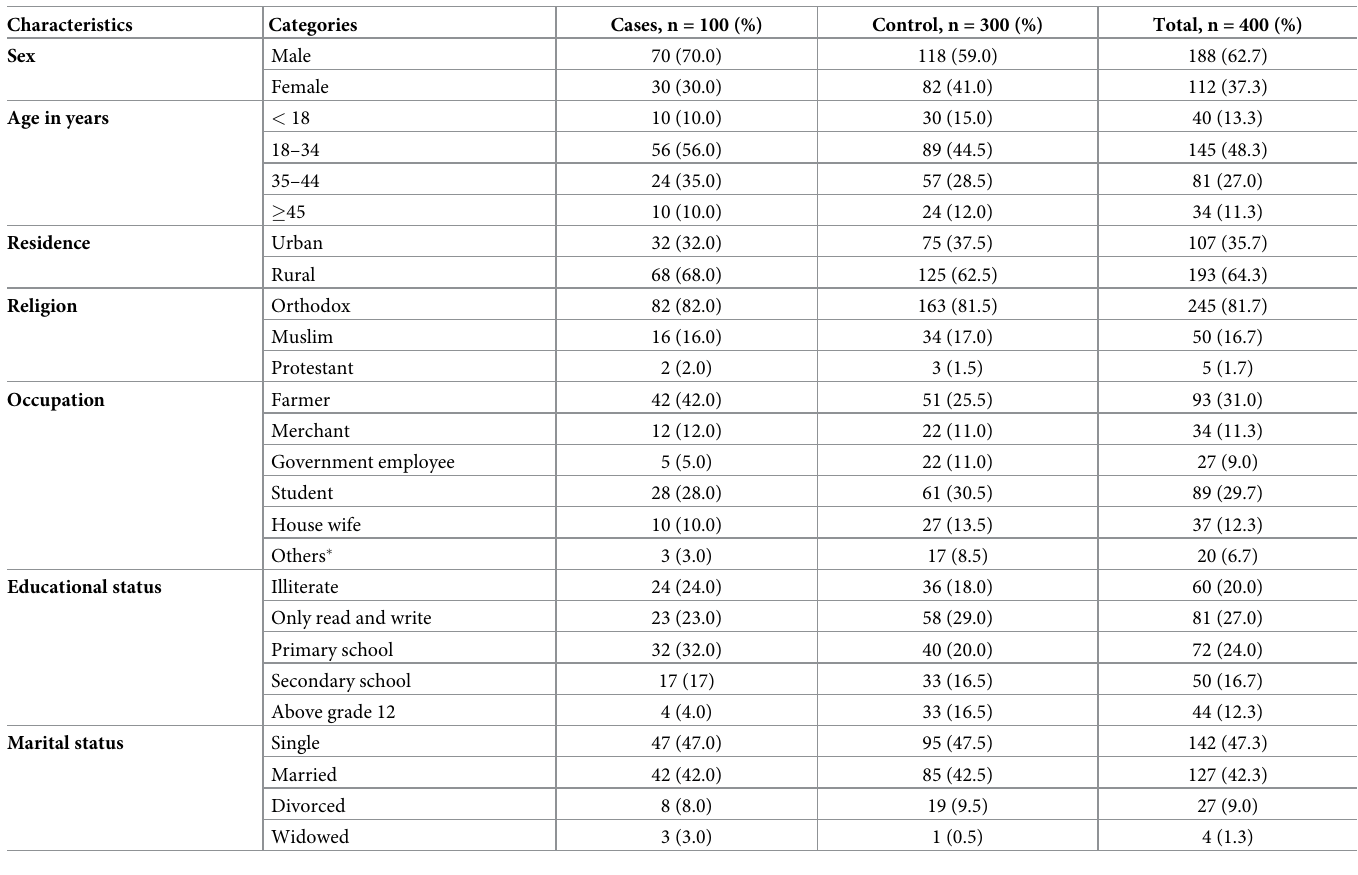
Table 1. Socio-demographic characteristics of the study subjects at South Gondar zone, Northwest Ethiopia.